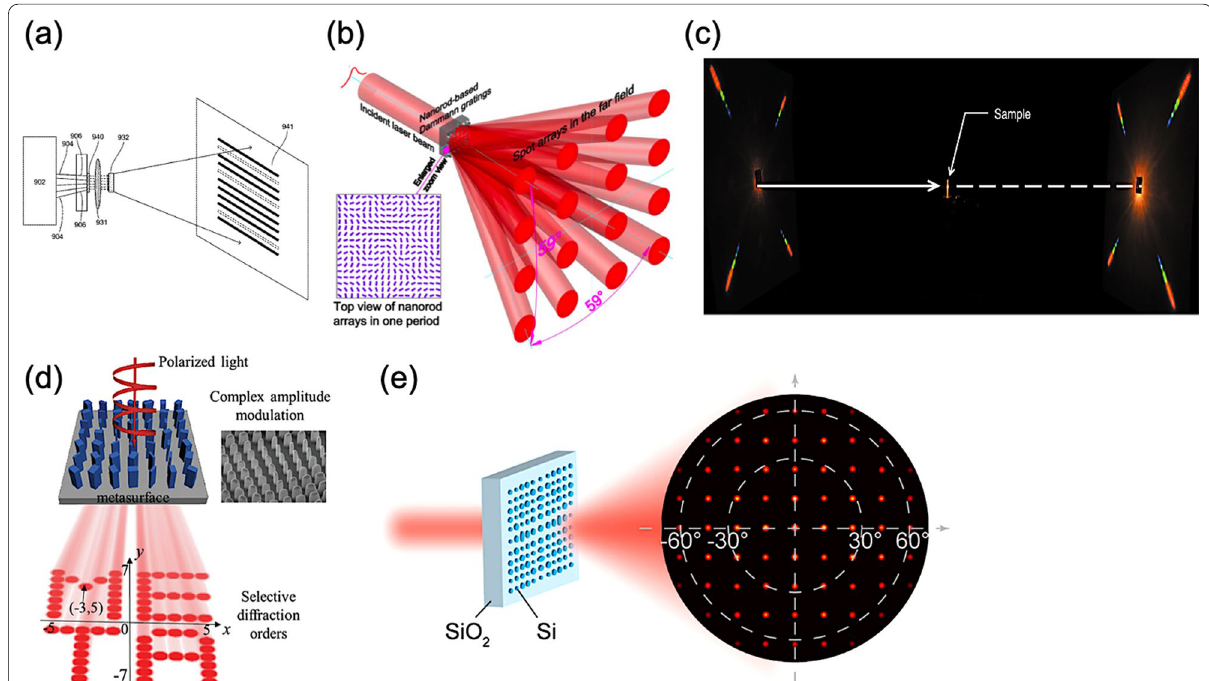
Fig. 10 Structured light projection with metasurfaces a A typical structured light projector consisting of a light source, a collimator lens, and a diffractive optical element (DOE) [102, 103], b All‑silicon nanorod‑based Dammann gratings for splitting incident beam into spot arrays [122], c Full‑space cloud of random points with a scrambling metasurface [123], d Complex amplitude modulation of the selective diffraction with a dielectric metasurface [124], and e Metasurface for structured light projection with 120° field of view